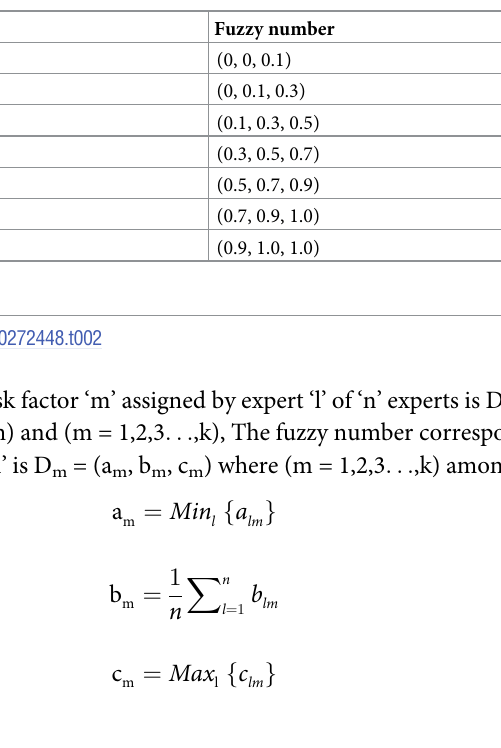
Table 2. Linguistic